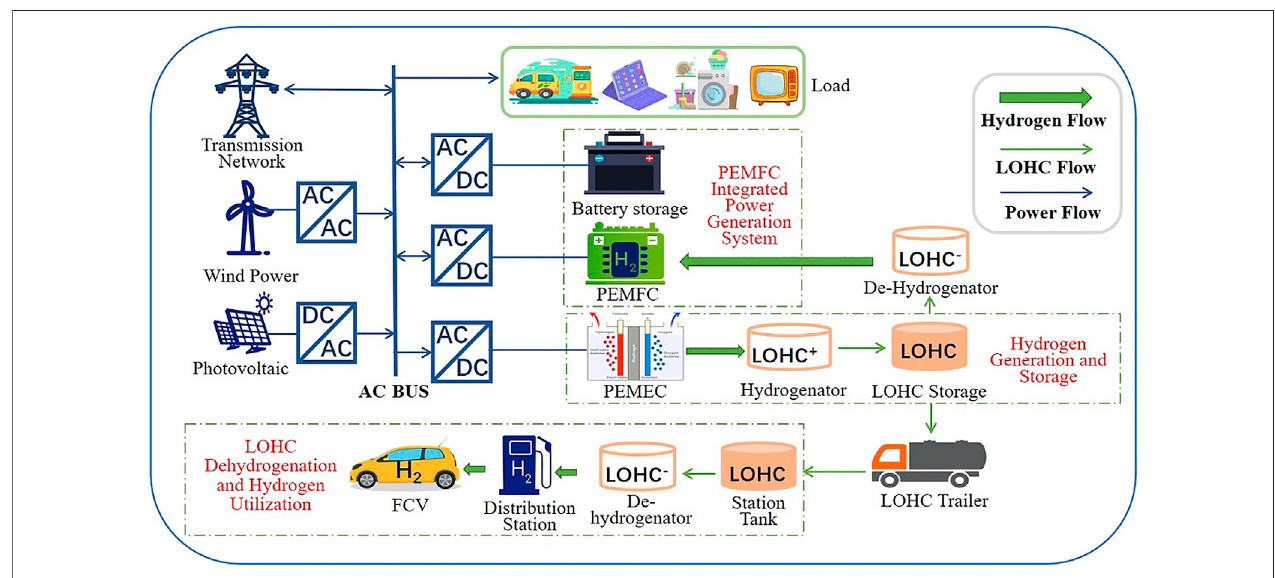
FIGURE 1 | The structure of